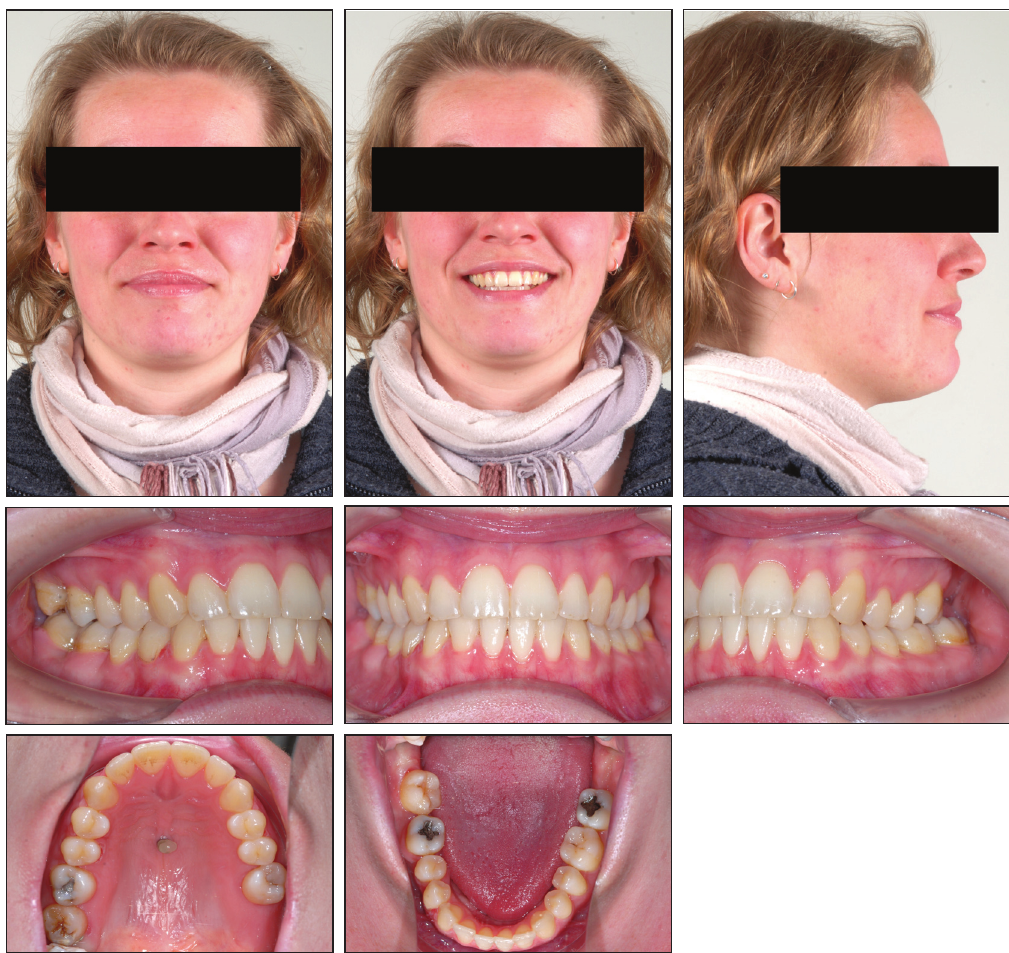
Figure 10. Facial and intra-oral photographs immediately after debonding of all appliances. The palatal mini-implant seen here was removed soon after this time-point.